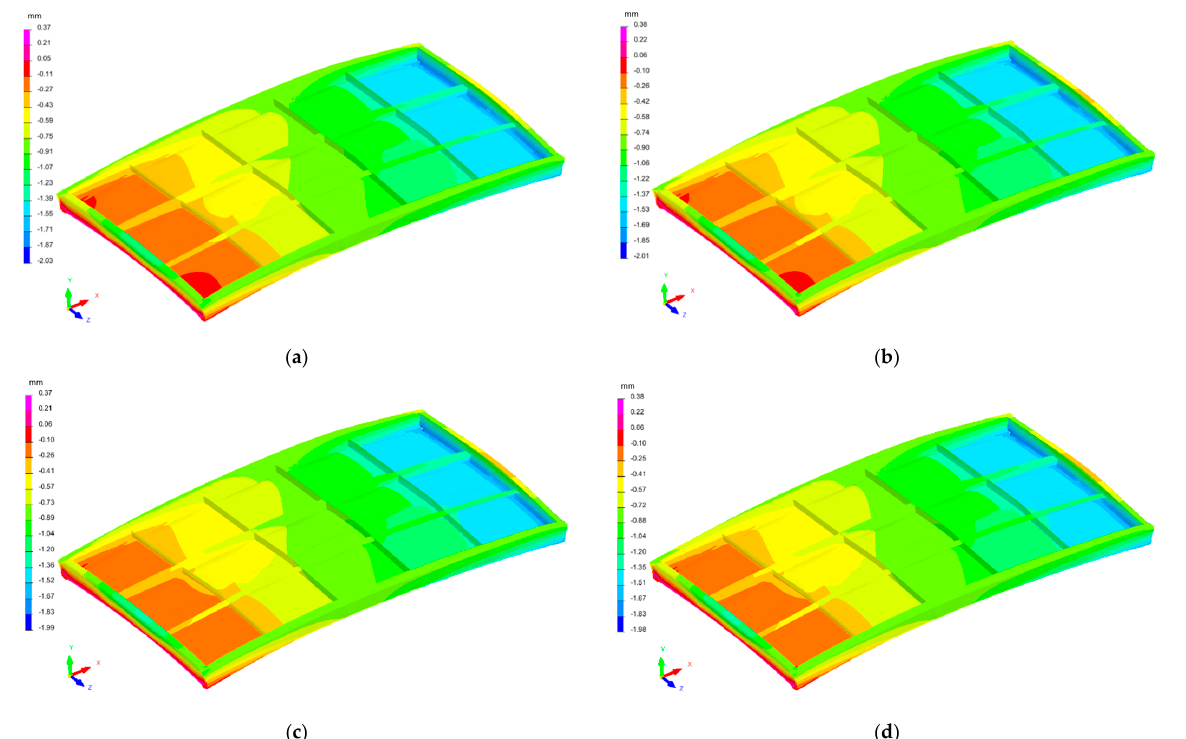
Figure 10. Distribution of the strain field of the industrial furnace wall panel in the X direction; ( a ) 1st restraint model, ( b ) 2nd restraint model, ( c ) 3rd restraint model, and ( d ) 4th restraint model.